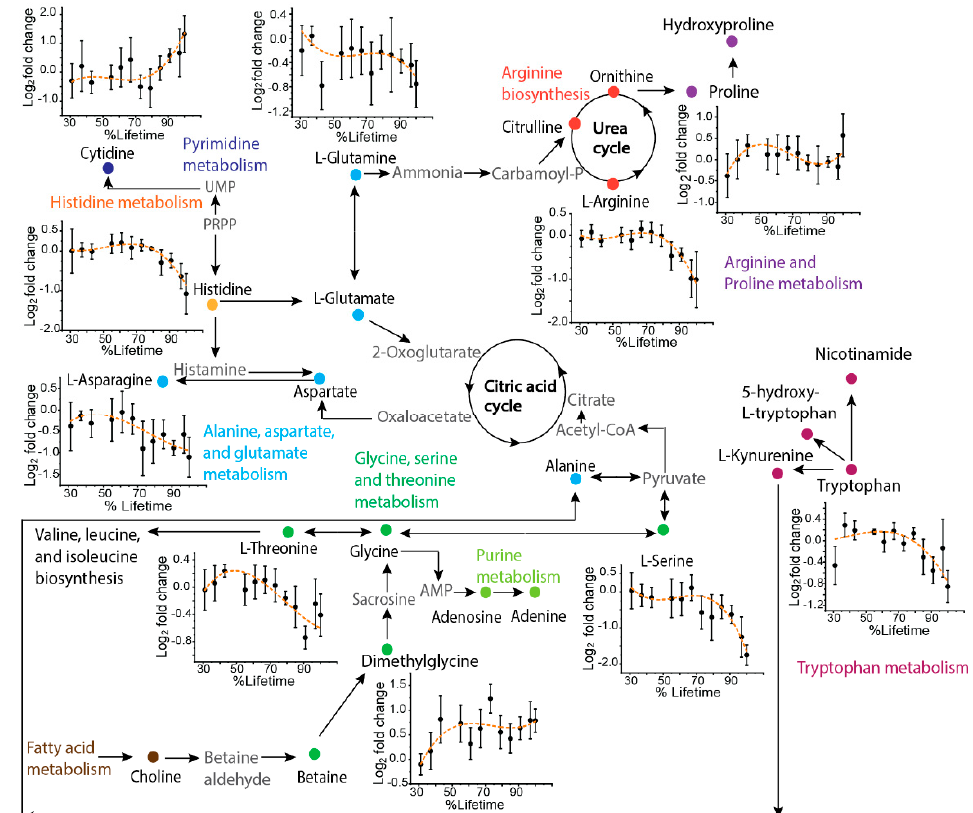
Figure 2. Pathway map showing a selection of key metabolites analyzed by µ CE-HRMS that track HGSC progression. Metabolites targeted in this study are shown as solid symbols and intermediates connecting the pathways are shown in grey text. Time-resolved serum metabolic trajectories for TKO mice are shown for select metabolites. For time-resolved plots, the x -axis shows the % lifetime, calculated as the ratio of the age of the mouse at a given serum sampling time point compared to the total lifespan of that specific animal. The y -axis shows the fold change calculated as the base 2 logarithm of the abundance in TKO/TKO control samples. Positive values indicate higher serum levels in TKO animals and negative values indicate lower serum levels in TKO animals compared to TKO controls. Error bars represent the standard error of the log 2 fold change between TKO and control samples.